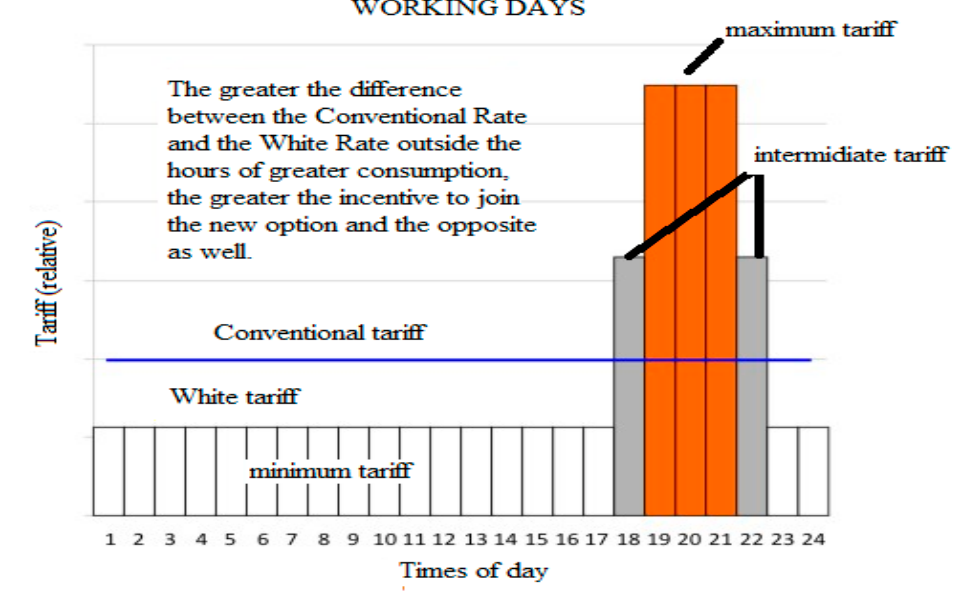
Figure 4. Comparative graphic representation of billing options for residential consumption. Source: ANEEL [44].